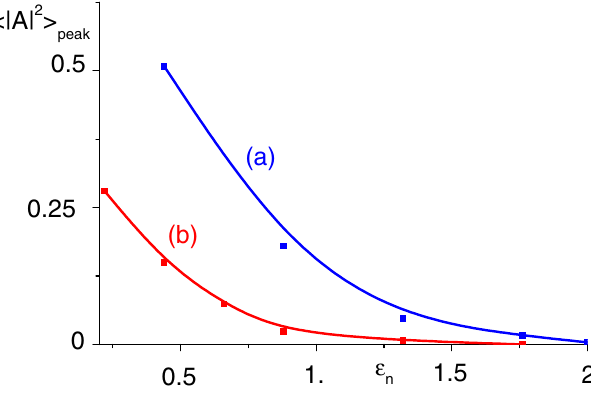
FIG. 7. (Color) hj A j 2 i (cid:4) !=! (cid:4) 0 and for: (a) flat laser profile with w (cid:4) 0 : 8 and (b) Gaussian laser profile with (cid:2) a (cid:2) a L 0 (cid:4) 106 (cid:11) m . (cid:2) L